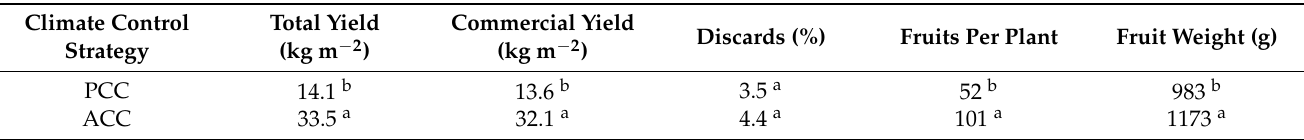
Table 2. Total and commercial yield, discards (%), fruit number per plant, and fruit weight in “Siluet” papaya grown in passive climate control (PCC) and active climate control (ACC) modules.